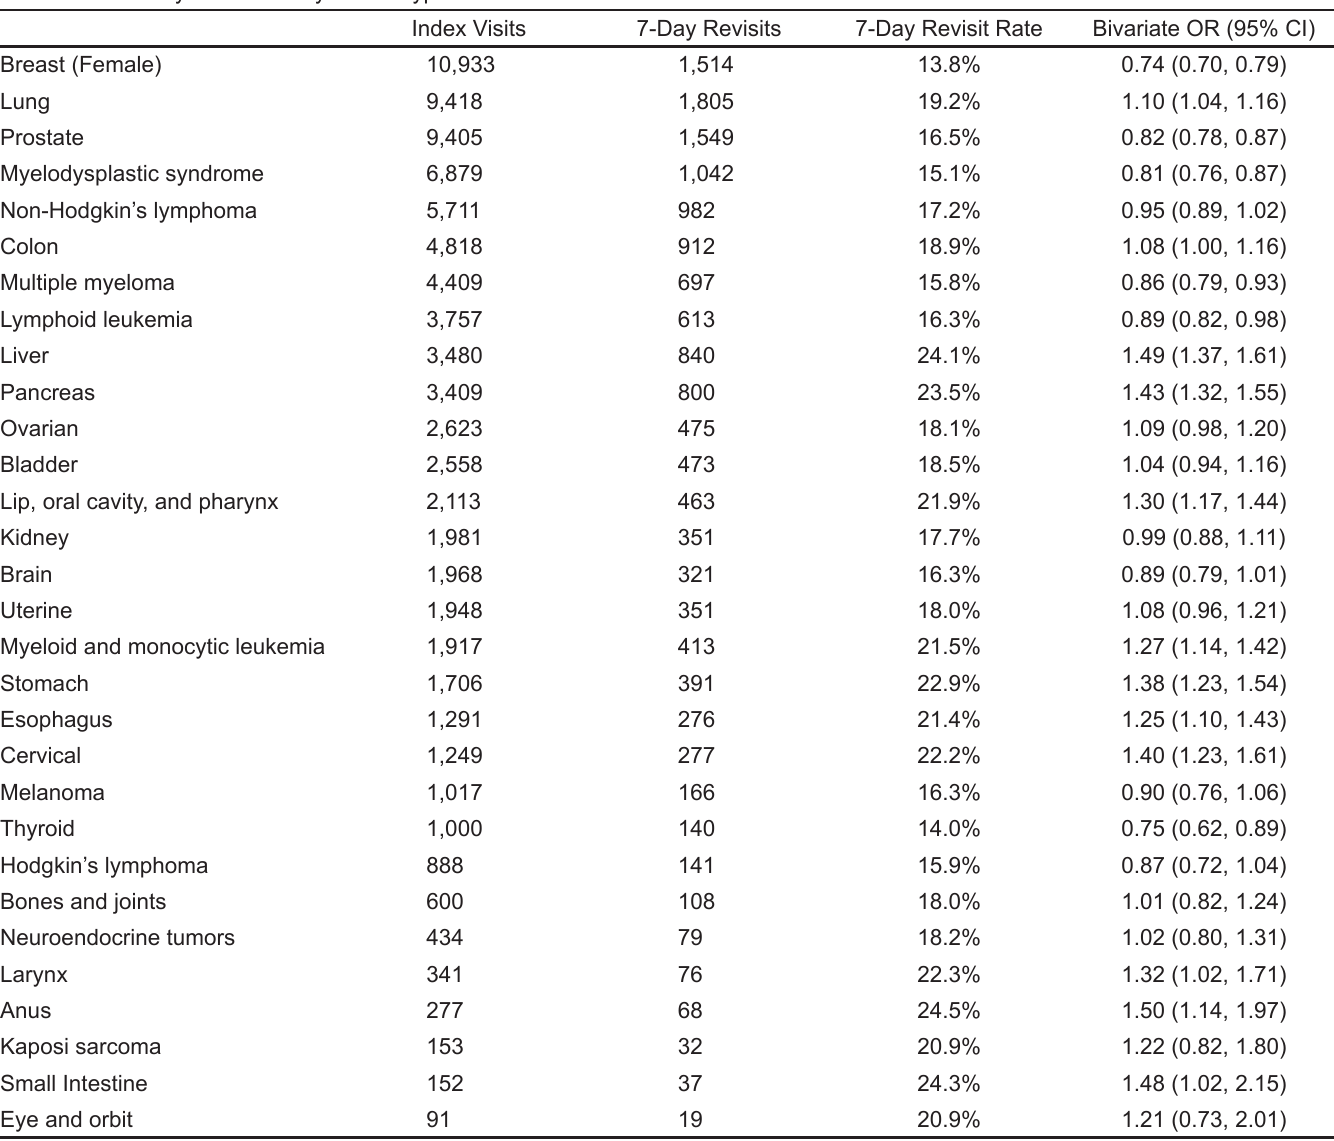
Table 3. Seven-day revisit rate by cancer